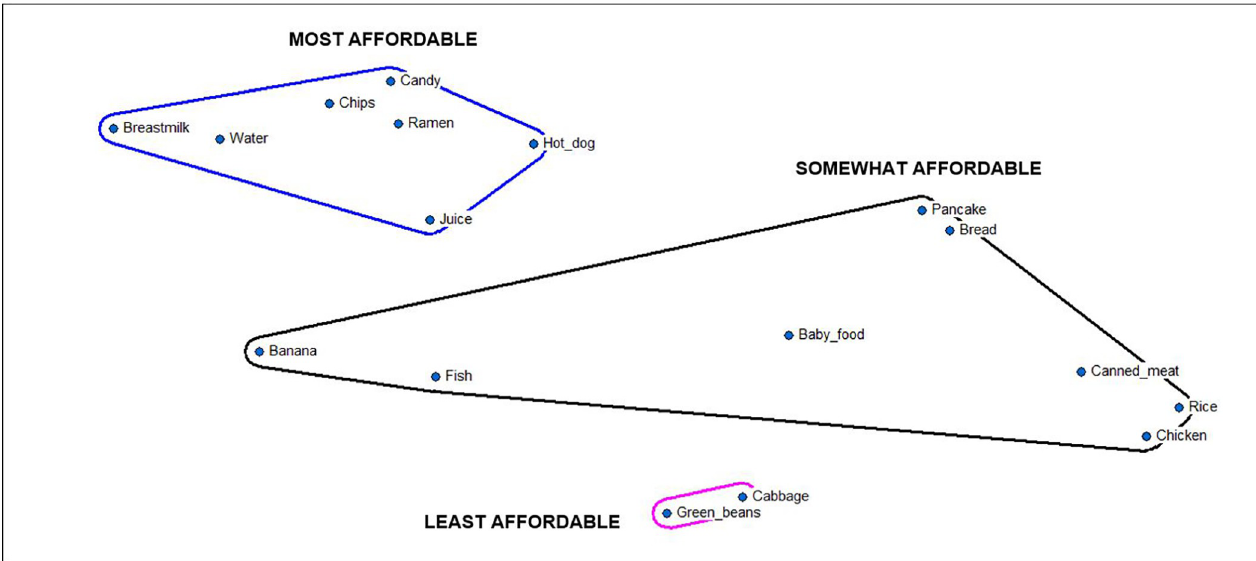
Fig 1. Multi-dimensional scaling map of infant and young child foods by affordability in urban Majuro. S = 0.11, Eigenvalue: 11.03, Eigenratio: 7.64.